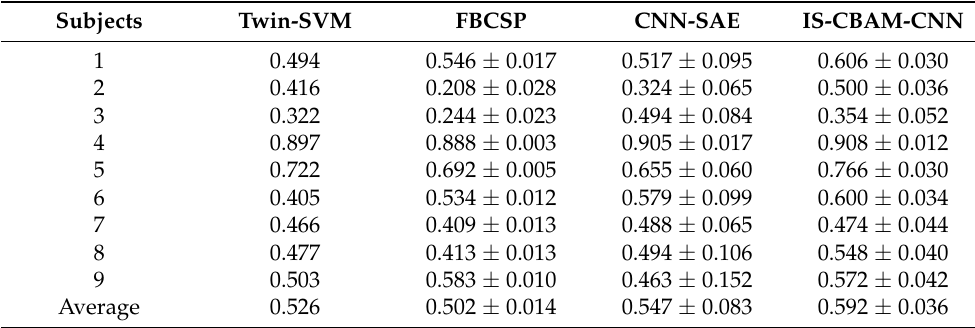
Table 2. Competition IV dataset 2b kappa coefficients results for Twin-SVM, FBCSP, CNN-SAE and